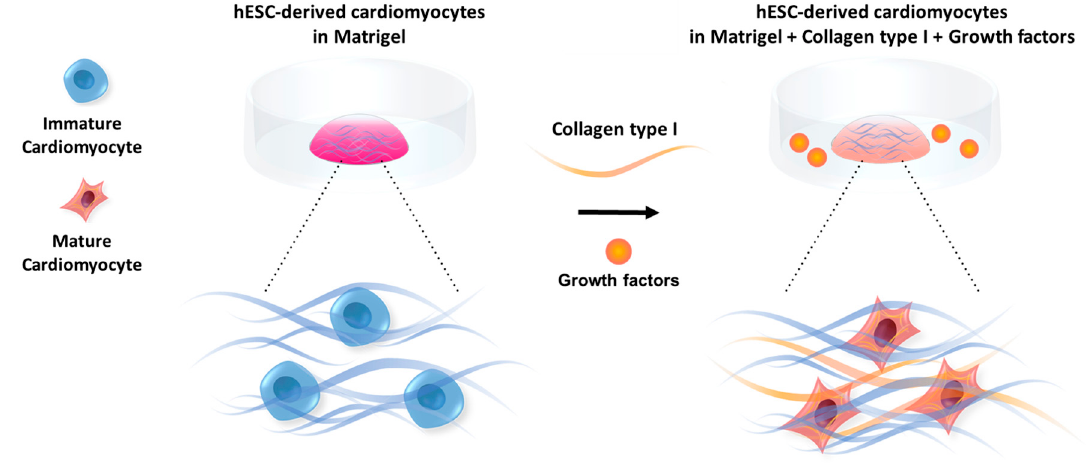
Figure 1. Maturation of cardiomyocytes encapsulated in hydrogels is influenced by the composition and stiffness of the ECM as well as growth factors (GFs).